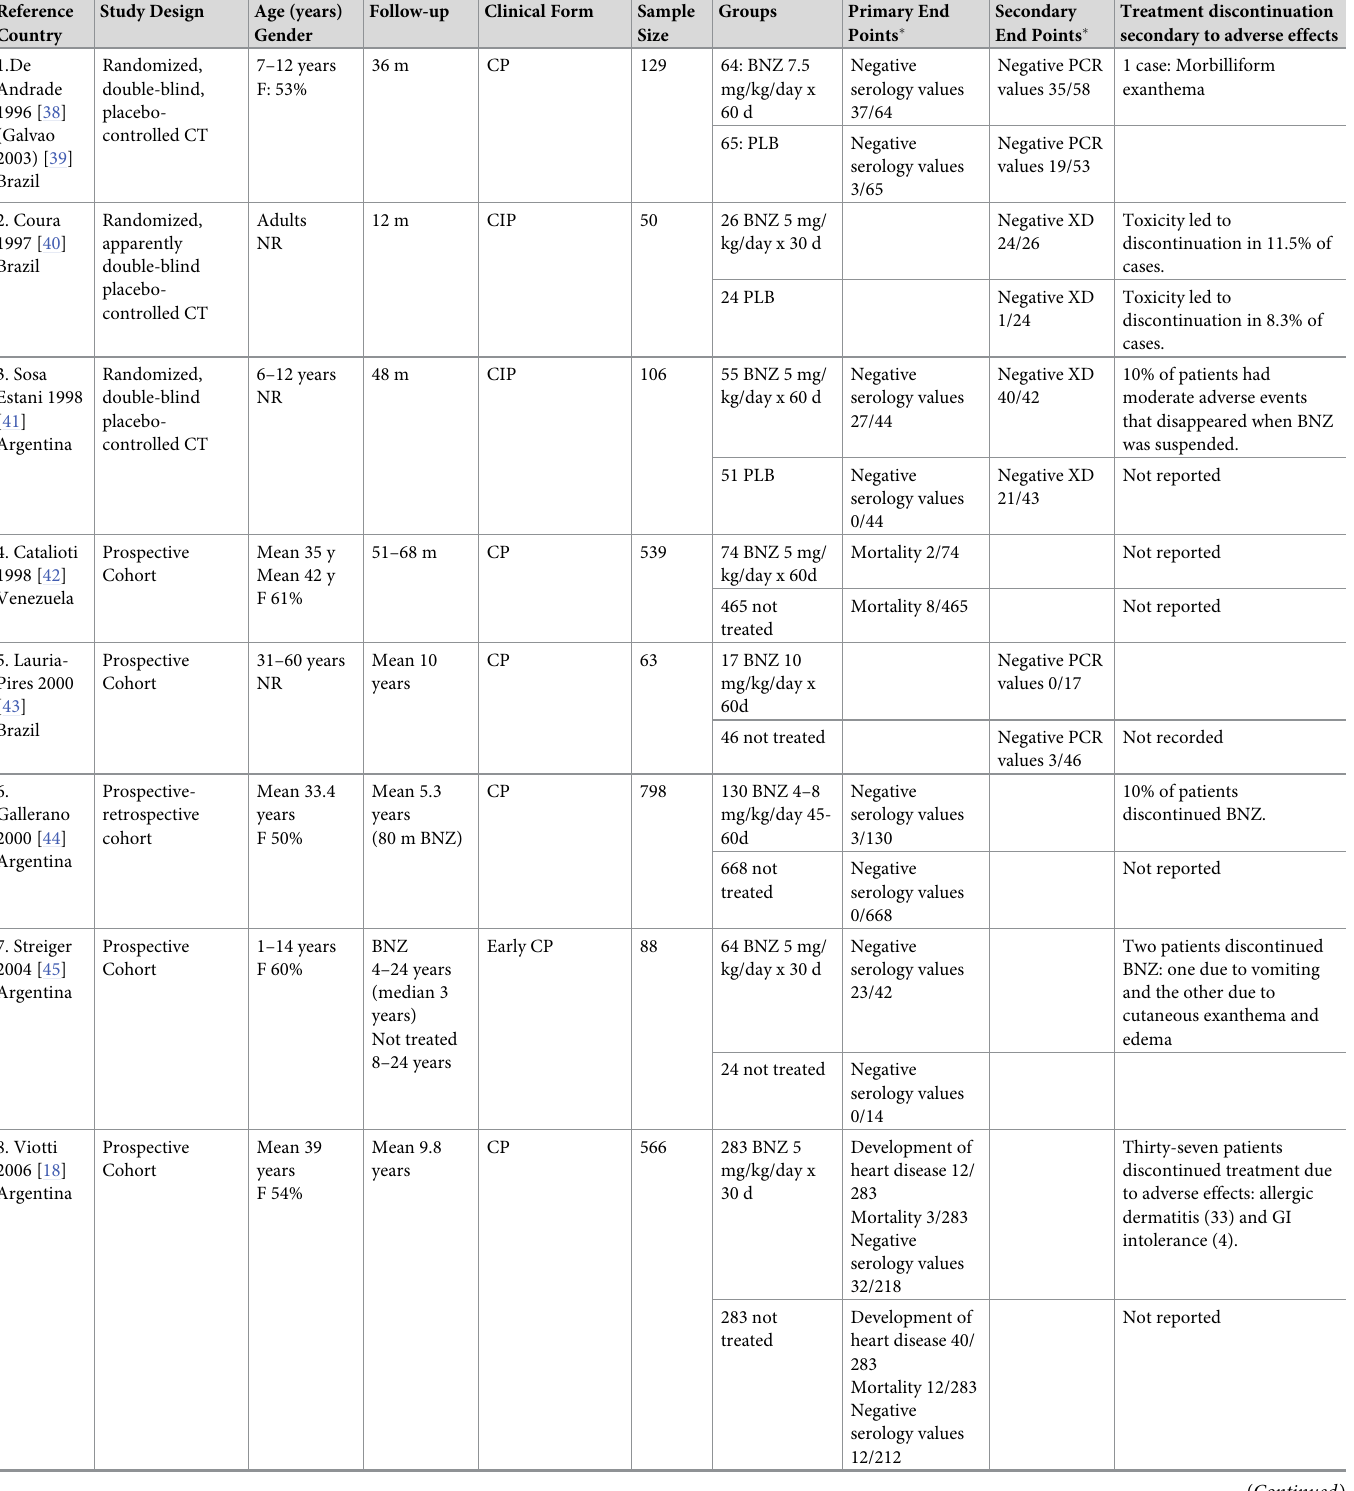
Table 1. Summary of the characteristics of the studies included in the systematic review. Reference